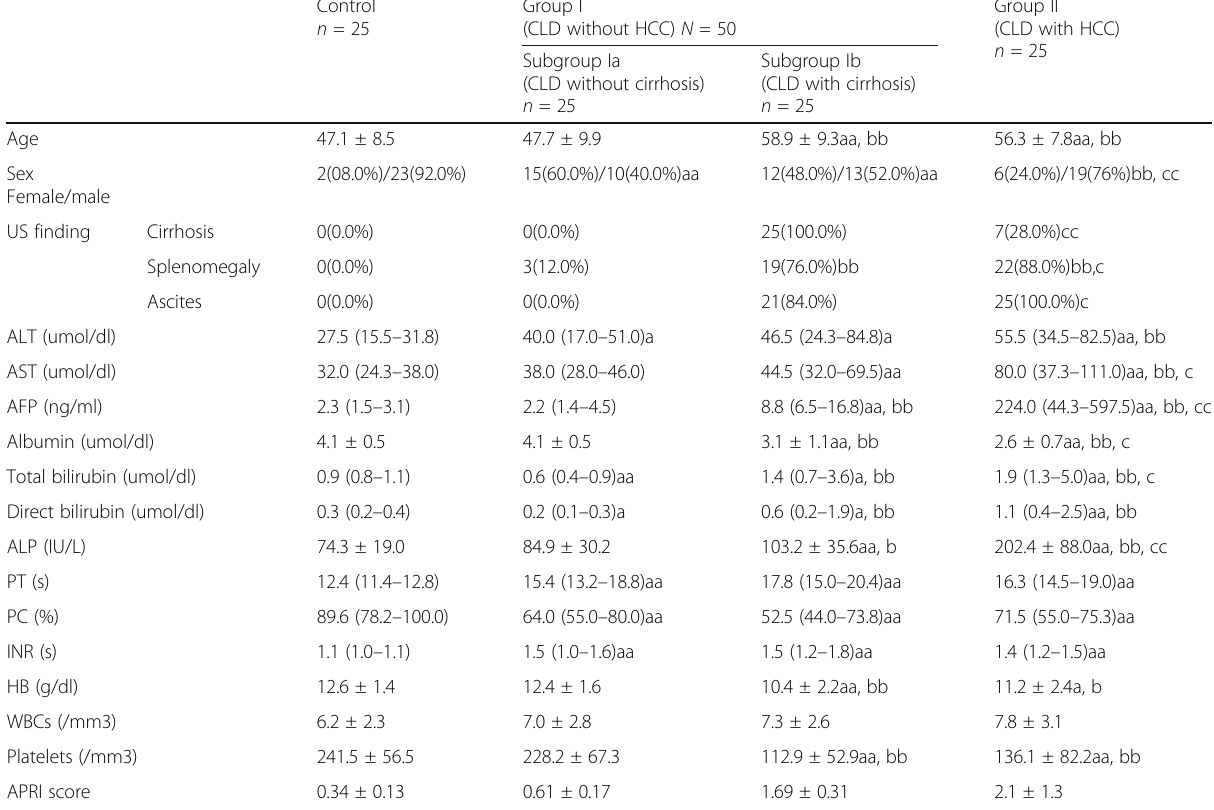
Table 2 Socio-demographic characteristics, laboratory investigations, and ultrasound finding among patients of the studied